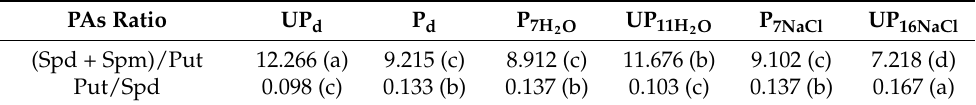
Table 1. PAs ratios calculated for seeds of Brassica napus before the start of germination (dry unprimed seeds, UP d and primed dried seeds, P d ) as well as during germination (primed seeds germinating 7 h in water, P 7H ; unprimed seeds germinating for 11 h in water, UP 11H 2 O for 7 h in NaCl, P 7NaCl ; unprimed seeds germinating for 16 h in NaCl, UP 16NaCl ). The same letters in each row of the table describe not significant differences between